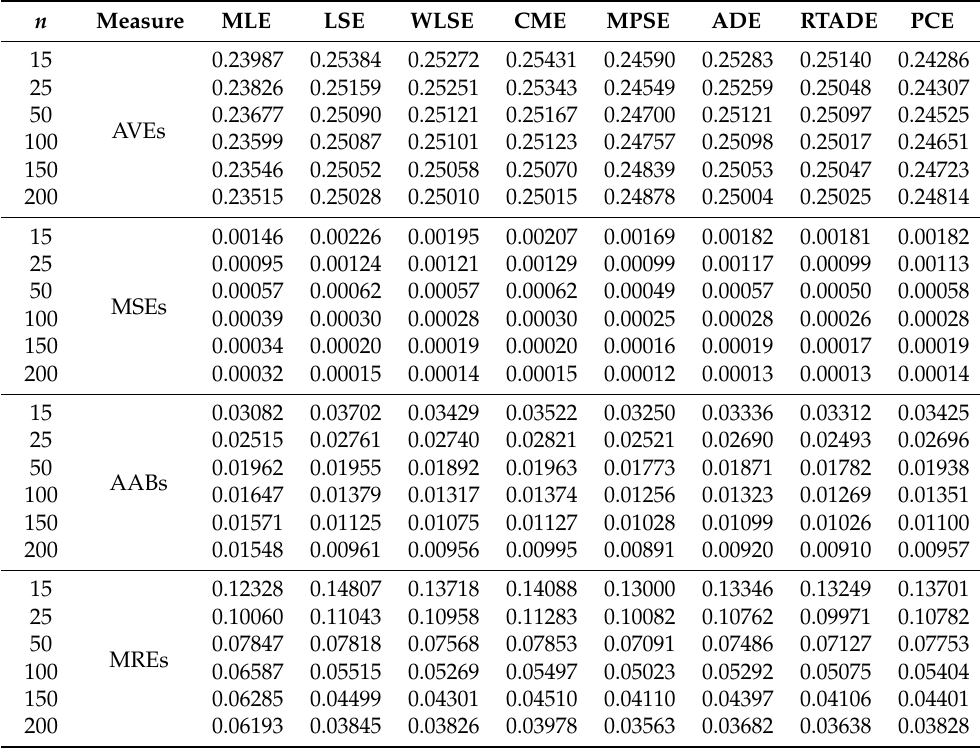
Table 2. Simulation results for the NDL distribution for θ =